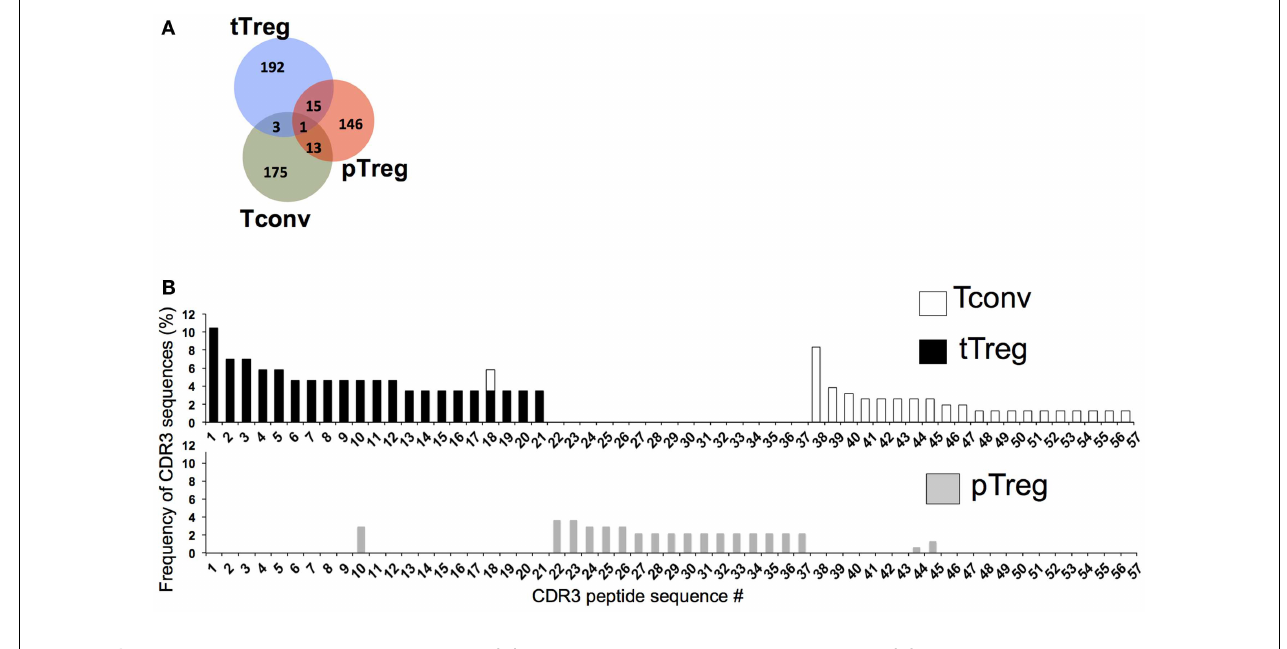
FIGURE 3 | DistinctTCR repertoire of pTregs and tTregs . (A) Venn diagram showing distribution of unique and overlapping pTreg, tTreg andTconv CDR3 sequences. Nrp-1 hi tTregs, Nrp-1 lo pTregs and CD4 + Foxp3 − Tconv cells were sorted from MBP.TCR.Tg (1B3)-Foxp3.GFP mice. cDNA was amplified with V α 2-specific primers and amplicons were subcloned and sequenced to